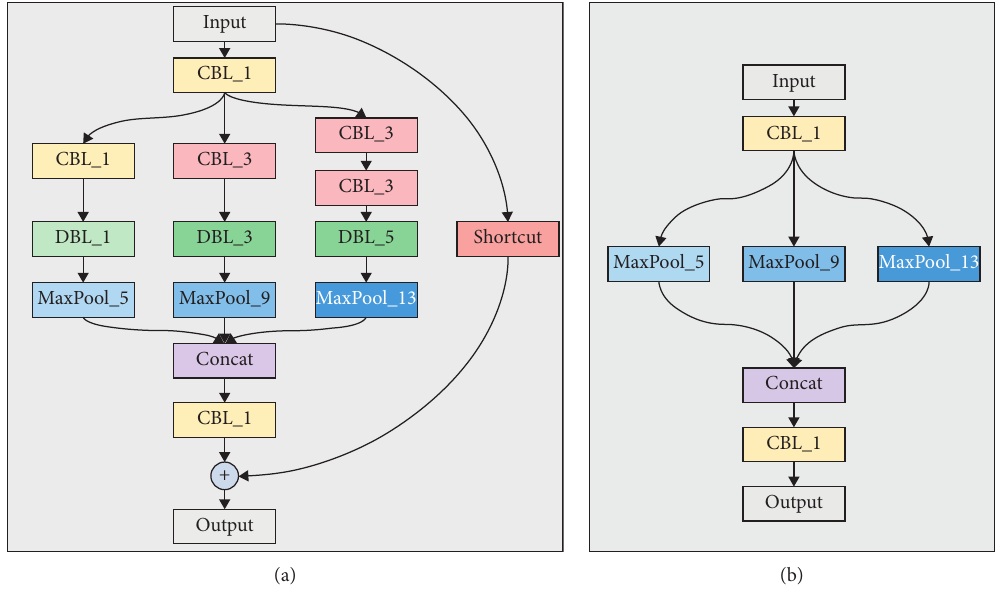
Figure 4: (a) DSPP structure in ShipYOLO. (b) SPP structure in